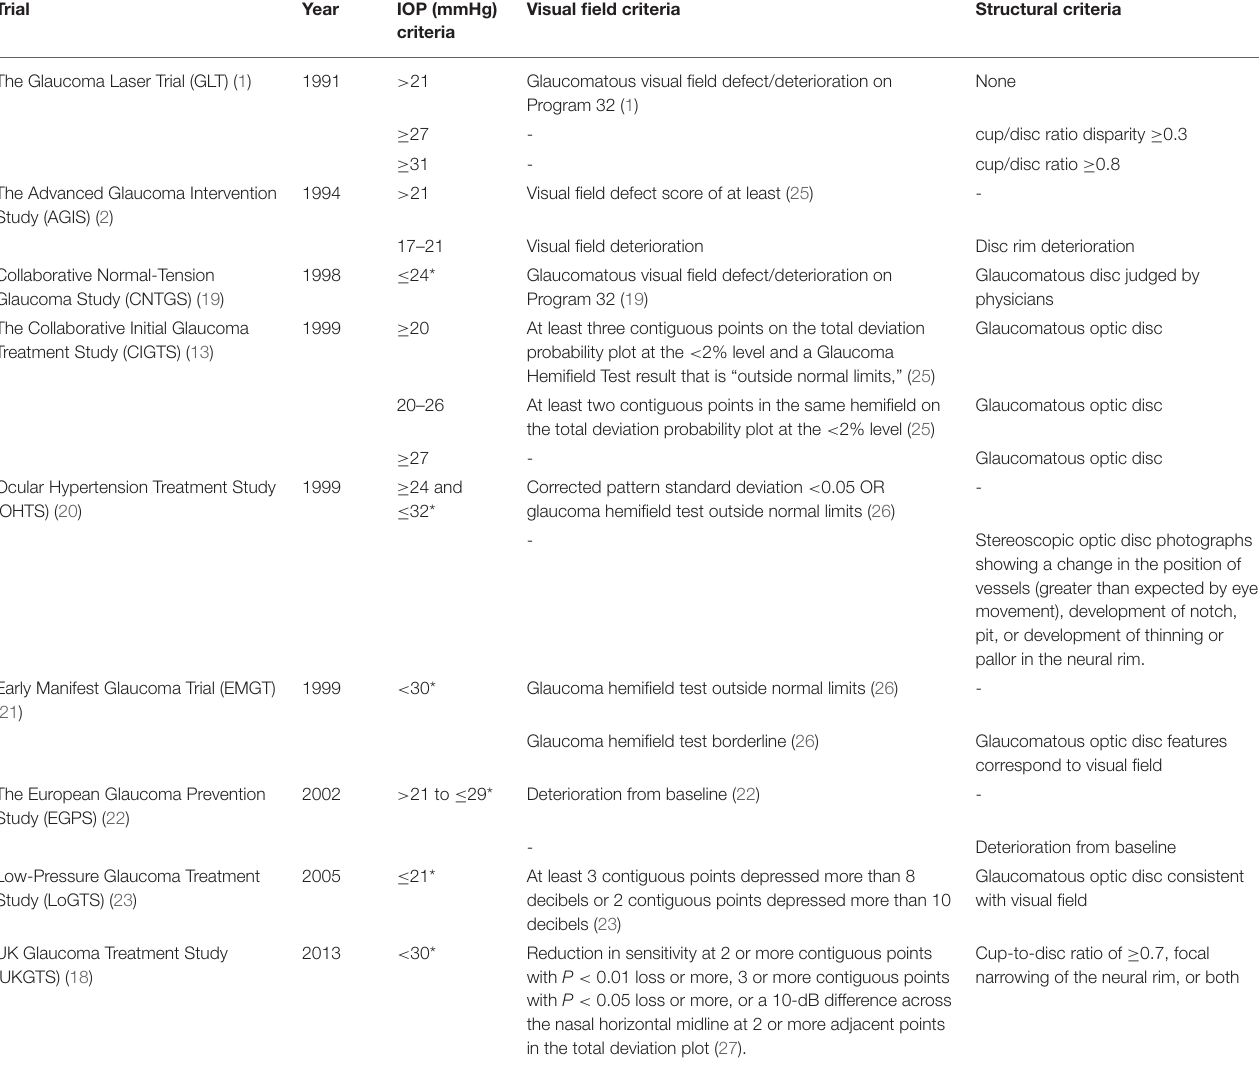
TABLE 1 | Landmark glaucoma clinical trials and each of the functional, structural, and intraocular pressure criteria used in glaucoma diagnosis or